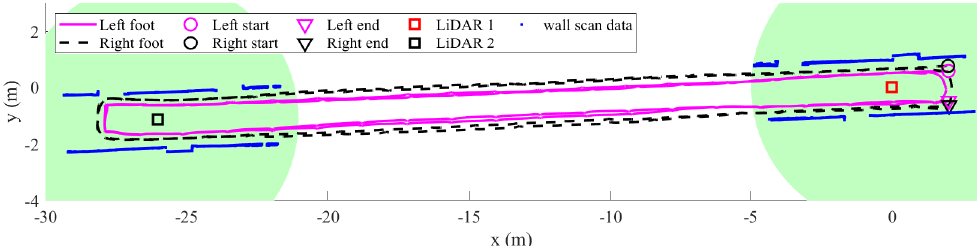
Figure 15. The estimated trajectory of proposed method in the rectangular path walking experiment. The shading circle area indicates the human leg tracking range of each LiDAR.